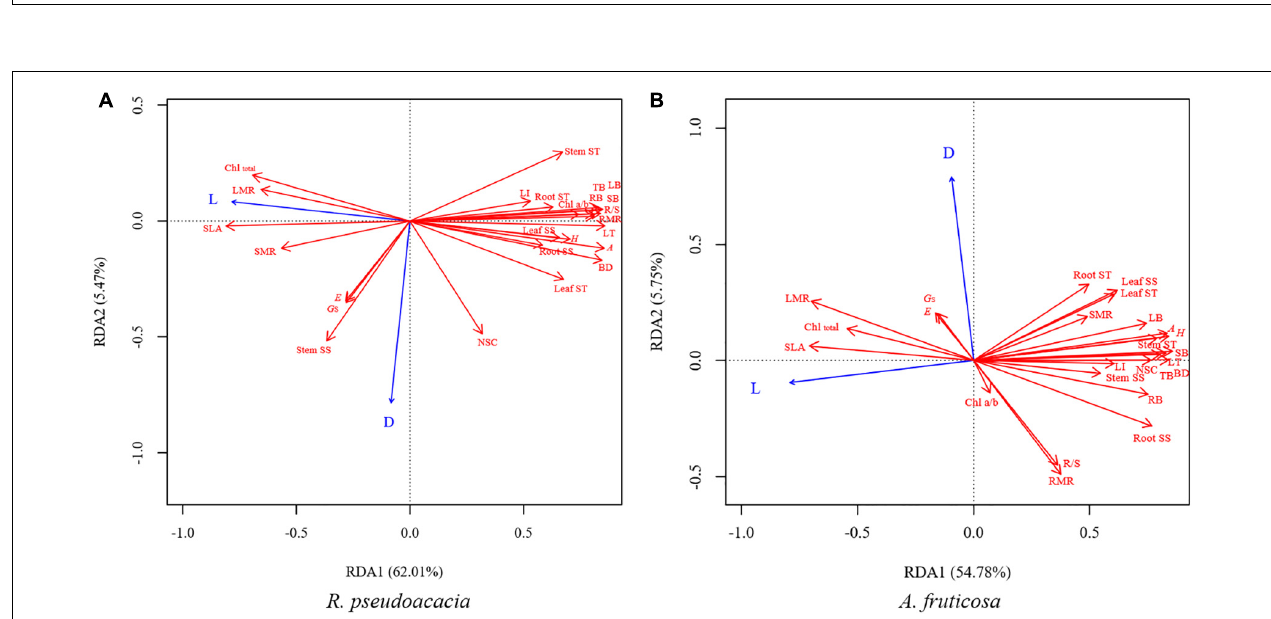
FIGURE 7 | Seedling soluble sugar and starch concentration of R. pseudoacacia (A,B,E,F,I,J) and A. fruticosa (C,D,G,H,K,L) under different defoliation and light treatments. Different letters indicate significant differences among different treatments at each sampling according to Duncan’s test ( p < 0.05). L + CK, high light condition with no defoliation; L + DE, high light condition treatment with defoliation; L − CK, low light condition with no defoliation; L − DE, low light condition with defoliation.